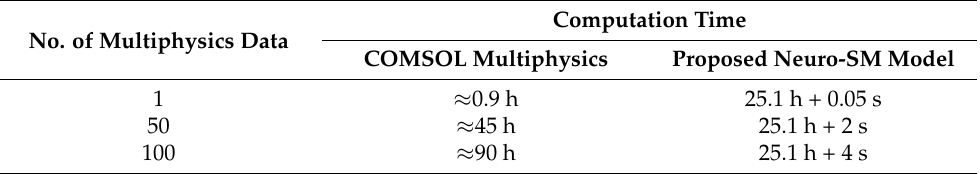
Table 6. Comparison of computation time between the multiphysics software simulation and the proposed Neuro-SM multiphysics model (25 data points) for the three-pole waveguide filter.